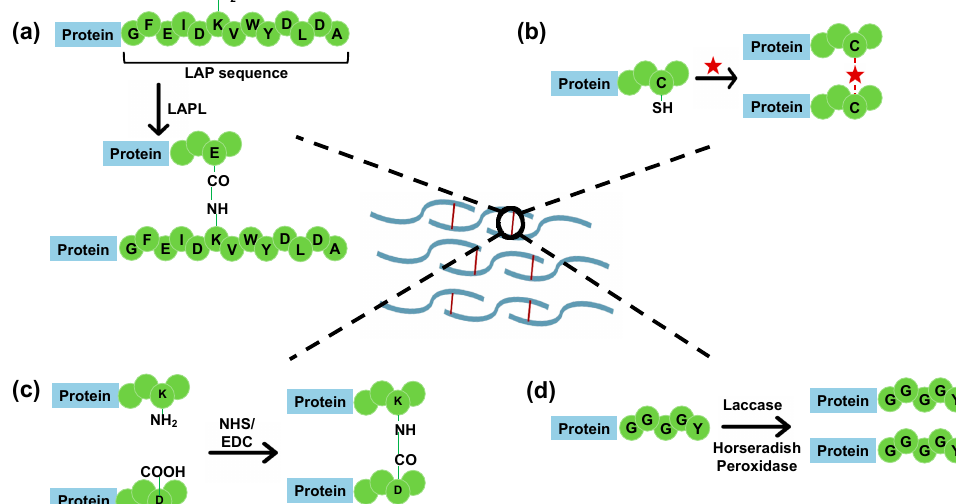
Figure 5. Various protein crosslinking strategies using side-chain chemistry. ( a ) Lipoic acid protein ligase mediated crosslinking that targets the LAP sequence for formation of an intermolecular amide bond. ( b ) Cysteine-specific conjugation using homobifunctional linkers such as maleimide (marked with red star in figure). ( c ) Lysine-specific crosslinking catalyzed by 1-ethyl-3-(3- dimethylaminopropyl)-carbodiimide (EDC) and N-hydroxysuccinimide (NHS). ( d ) Tyrosine-specific crosslinking using enzymes such as laccase and horseradish peroxidase for the oxidation of phenol side chains.